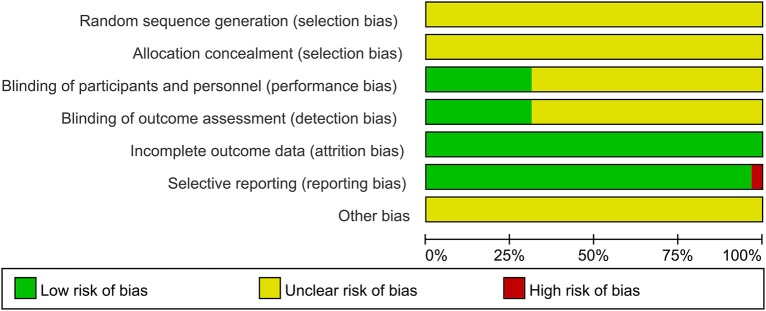
Graph of the risk of bias in the included trials by Cochrane risk of bias toll based upon reviewers' judgment of each domain.